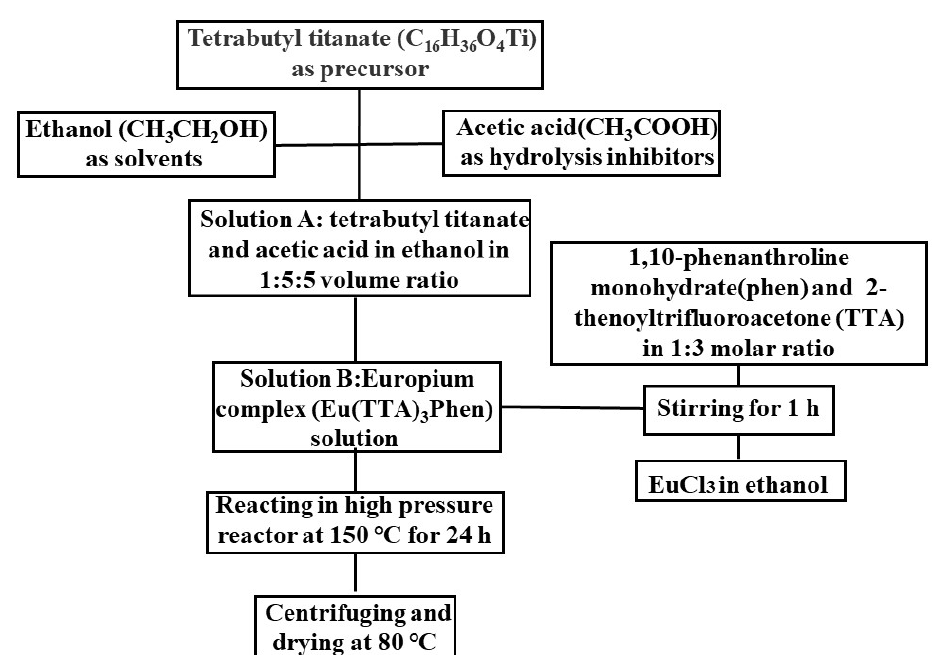
Figure 2. Flow chart of TiO 2 ‐ ETP preparation.